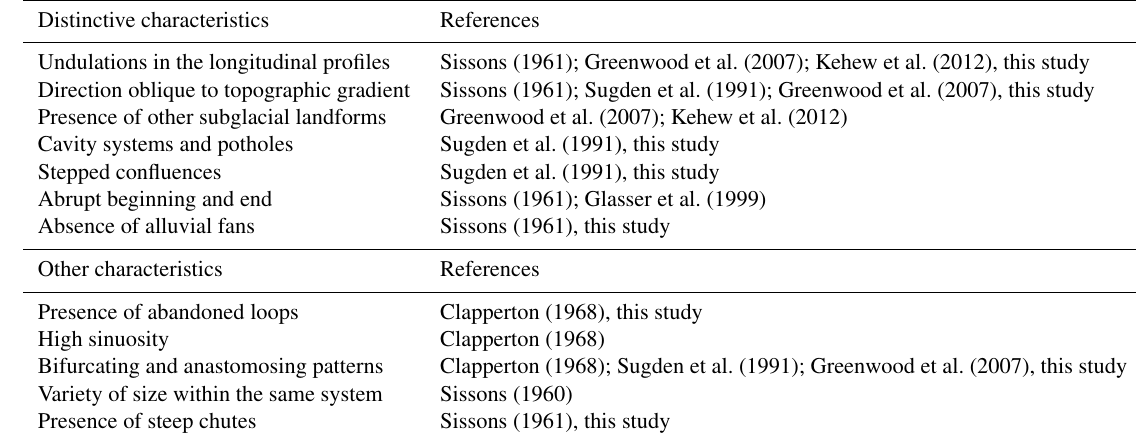
Table 1. Diagnostic criteria for the identification of subglacial